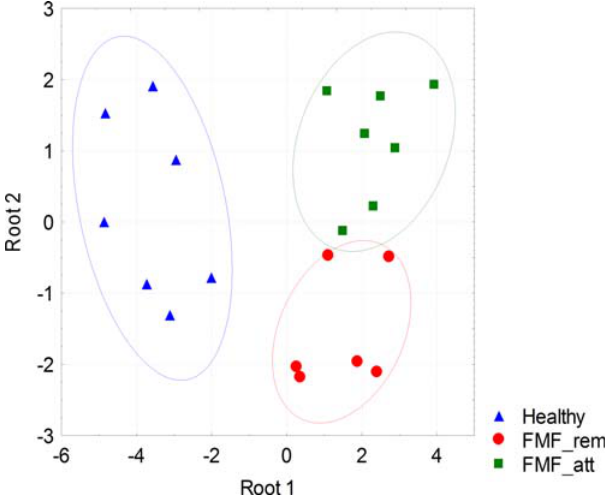
Figure 4. Discriminant function analysis of FISH data. Number of variables in model: 10; grouping - 3 groups. Wilks’s lambda coefficient – 0.045; F-test - (20,16)=2.95, p , 0.016. Root 1, 2 – discriminant functions 1 and 2 (1 st and 2 nd canonical roots). Regions of group distribution are outlined by ellipses; healthy is shown in blue triangles, remission – in red circles, and attack – in green squares.